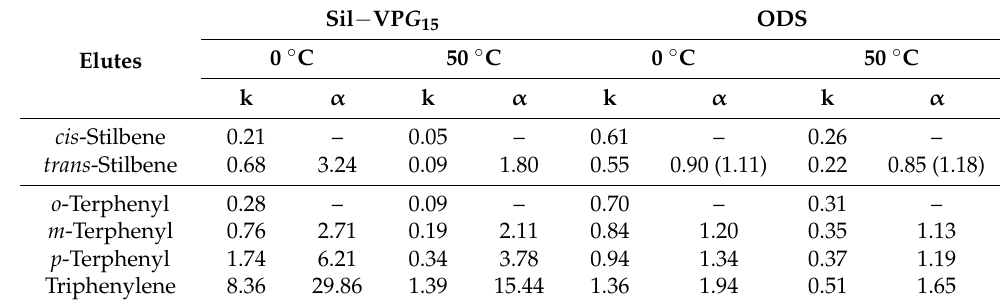
Mobile phase: Acetonitrile. Flow rate: 1.0 mL min −1 .